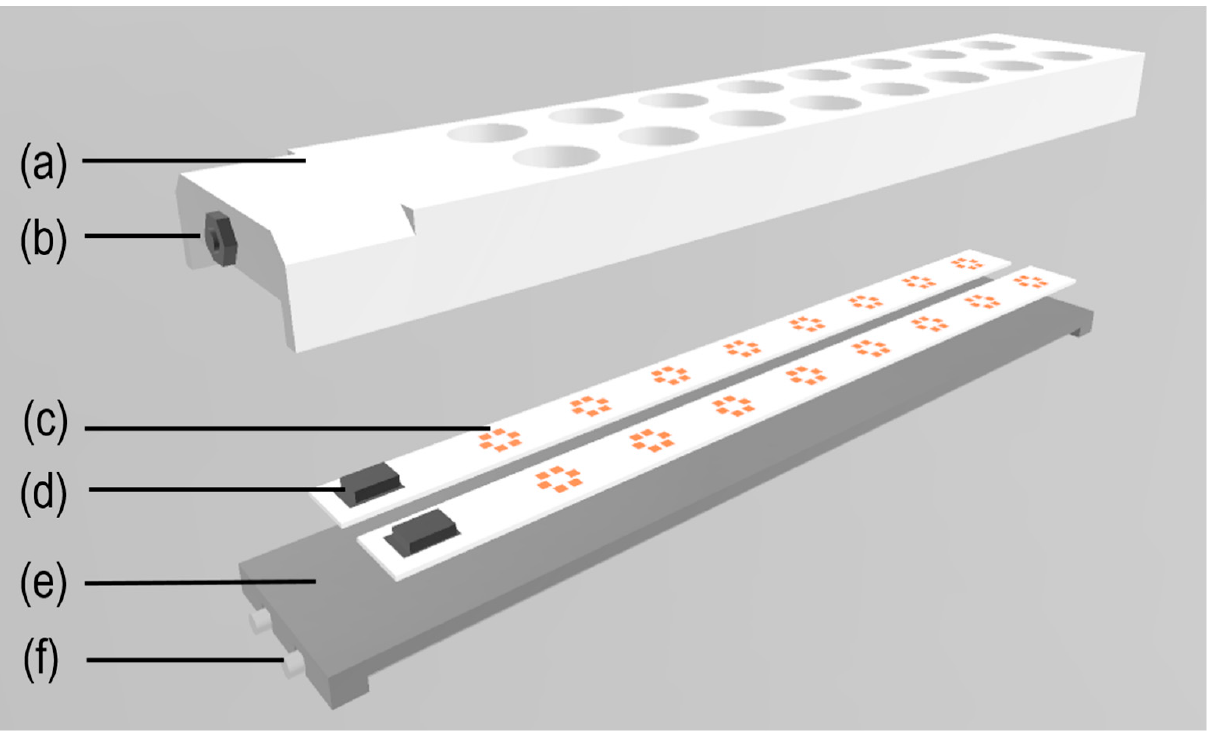
Figure 2. Illumination modules for two rows of mL-scale stirred-tank bioreactors: (a) housing in which all components are mounted, 6 LEDs positioned precisely below each bioreactor, individual lighting positions separated from external light and light from neighboring positions; (b) power supply jack SAL8 FK30; (c) two circuit boards for LEDs (yellow); (d) power socket connected to b; (e) aluminum heat exchanger; (f) inlet and outlet pipe for water cooling (rendered with 3D Builder, Microsoft Corporation, Redmond, DC, USA; CADrays, OpenCascade, Issy-Les-Moulineaux, France).